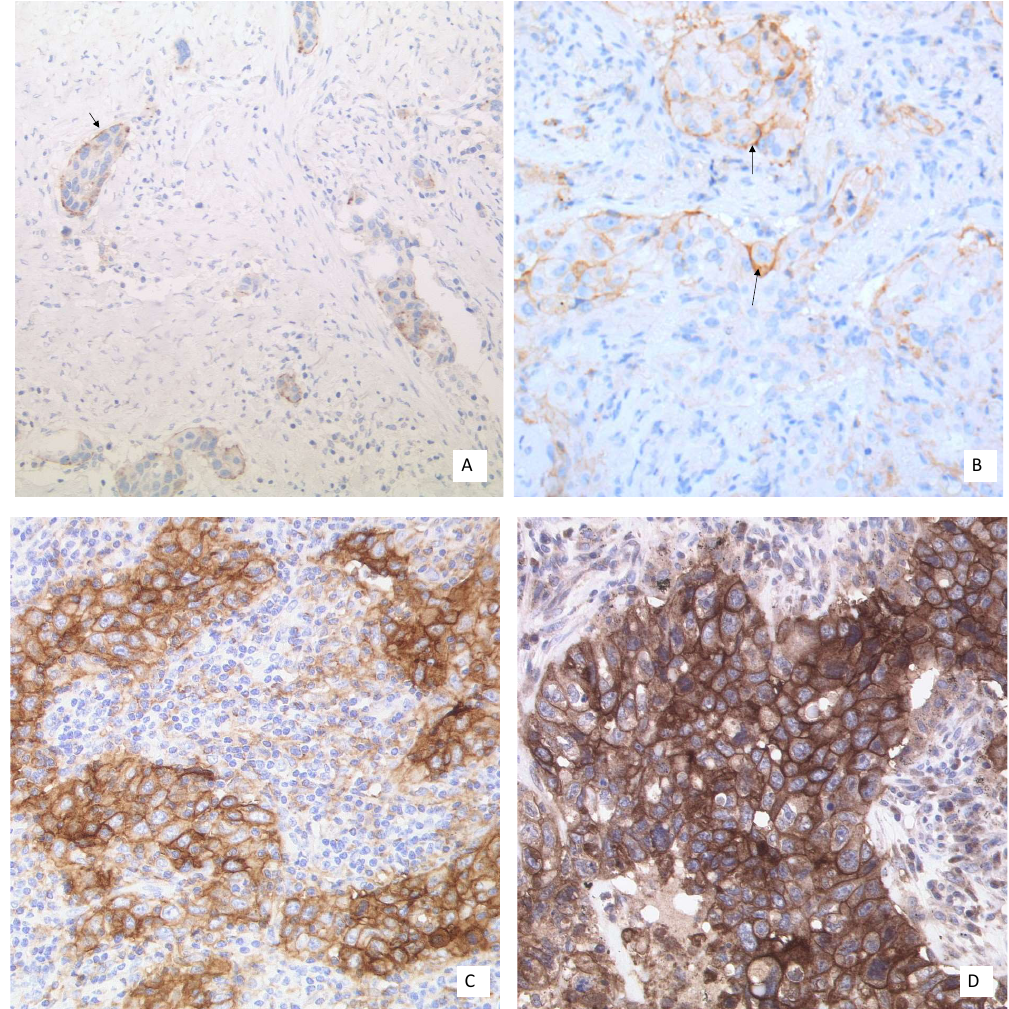
Figure 1. Different PD-L1 expression patterns in NSCLC tumor cells: ( A ) Basement membrane staining of moderate intensity (20 × Obj. magnification); ( B ) Basolateral membrane staining (arrow) of weak to moderate intensity (40 × Obj. magnification); ( C ) Moderate to strong membranous PD-L1 staining (40 × Obj.); ( D ) Strong membranous PD-L1 staining (40 × Obj.). ( B , C ) to be considered for scoring.